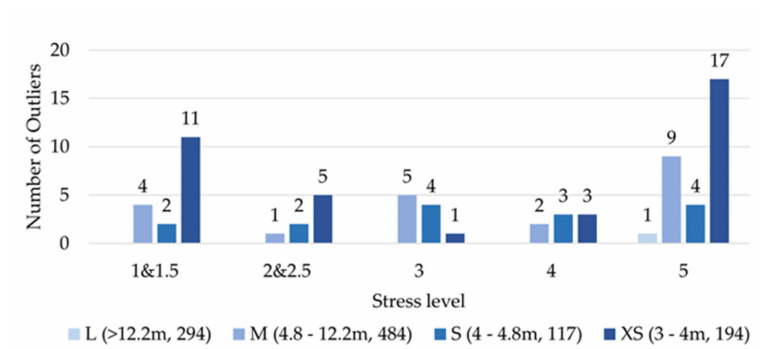
Figure 8. Bar chart showing the absolute numbers of outliers (error > 1) in four crown diameter classes (total 1089) and five aggregated stress levels for a random forest (RF) regression with nine attributes in a 10-fold cross validation.